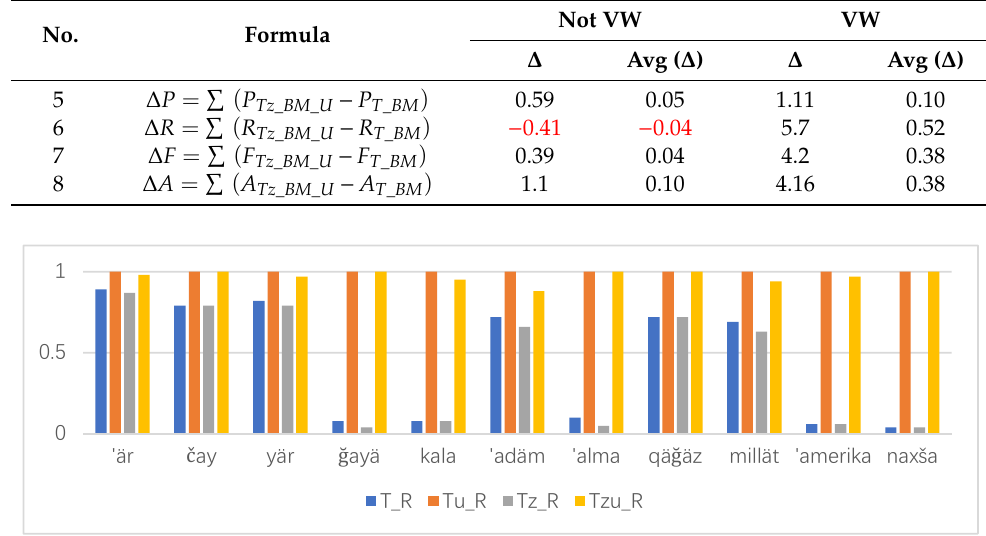
Figure 1. Comparison of BM-U and BM algorithm R-values of weakened words (u means BM-U algorithm).